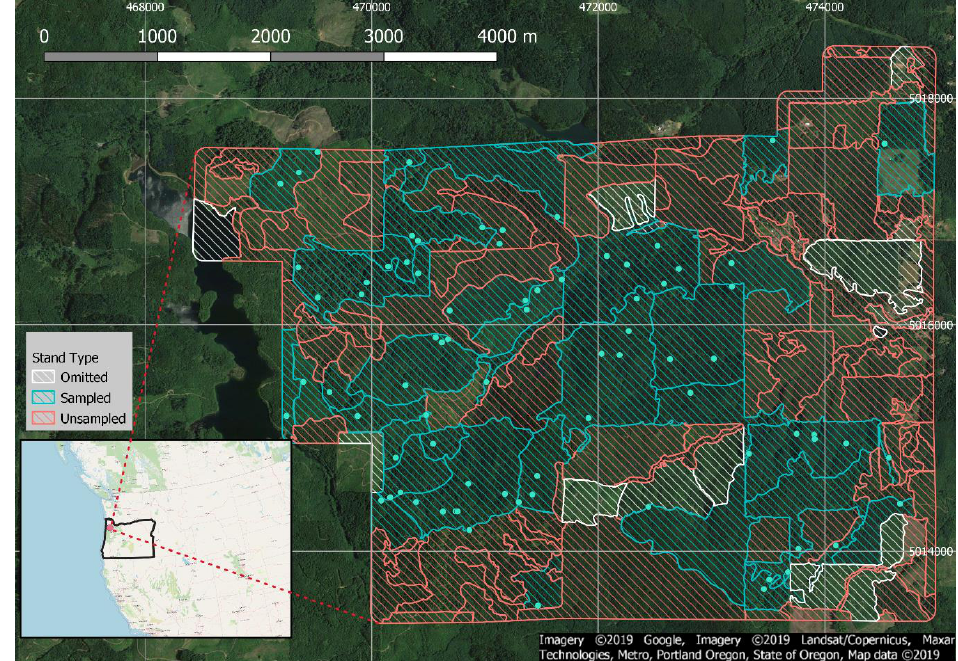
Figure 1. Vicinity map of the Panther Creek watershed situated in the northwest of Oregon, USA. Forest stands are colored according to omitted, sampled and unsampled. Field plots are indicated in blue. Universal Transverse Mercator (UTM) Zone 10 N coordinates are given at the margins of the figure, with UTM grid lines demarcated in gray.